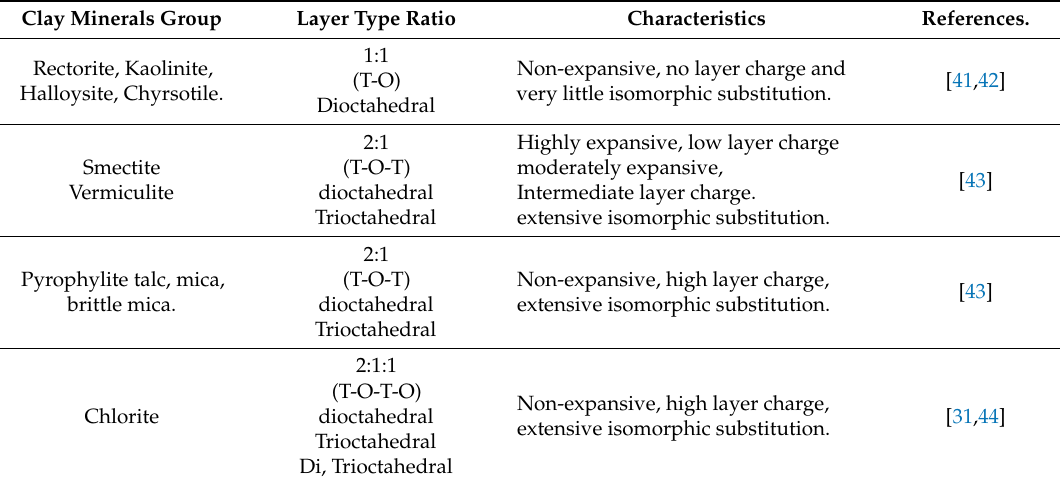
Table 2. Classification of clay minerals and their